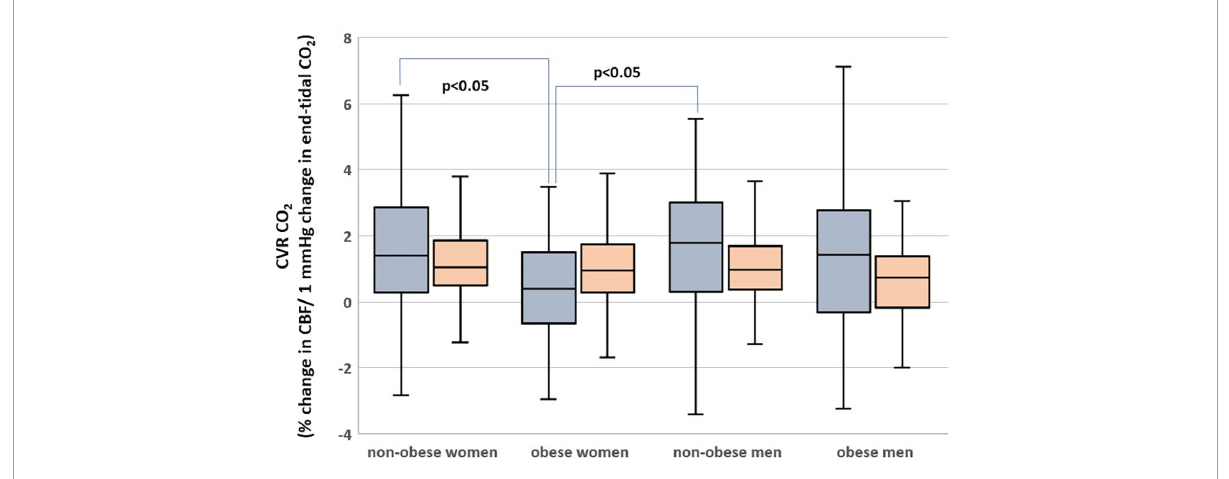
FIGURE3 Hippocampal (gray) and cortical (orange) cerebrovascular reactivity to CO 2 (CVR CO 2 ) in men and women with obesity and non-obese men and women.